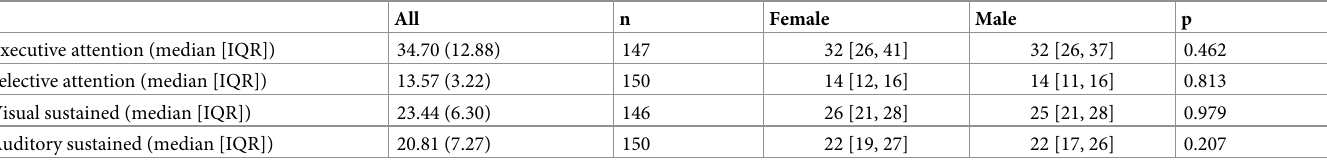
Table 2. Attention measures.